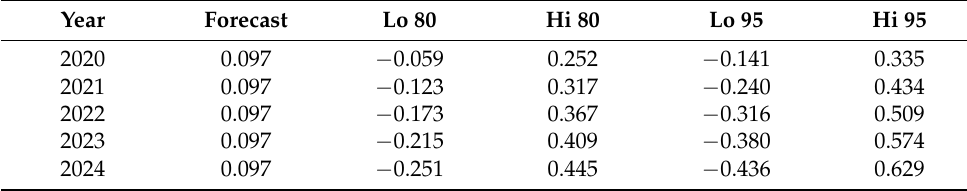
Figure 8. Forecast fish landings and CPUE from 2019 to 2024. Table 4. Forecast CPUE from 2019 to